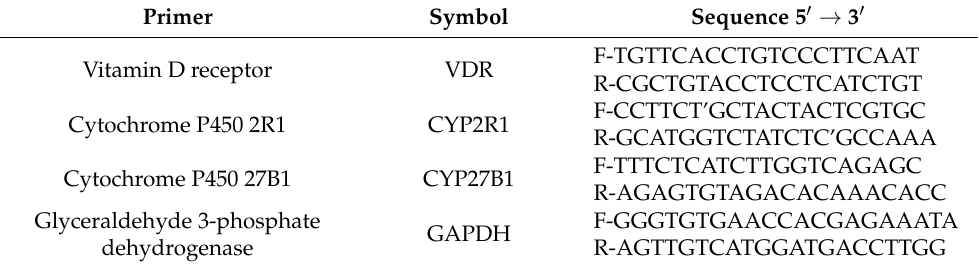
Table 2. List of primers and their sequences used for real-time PCR analysis.